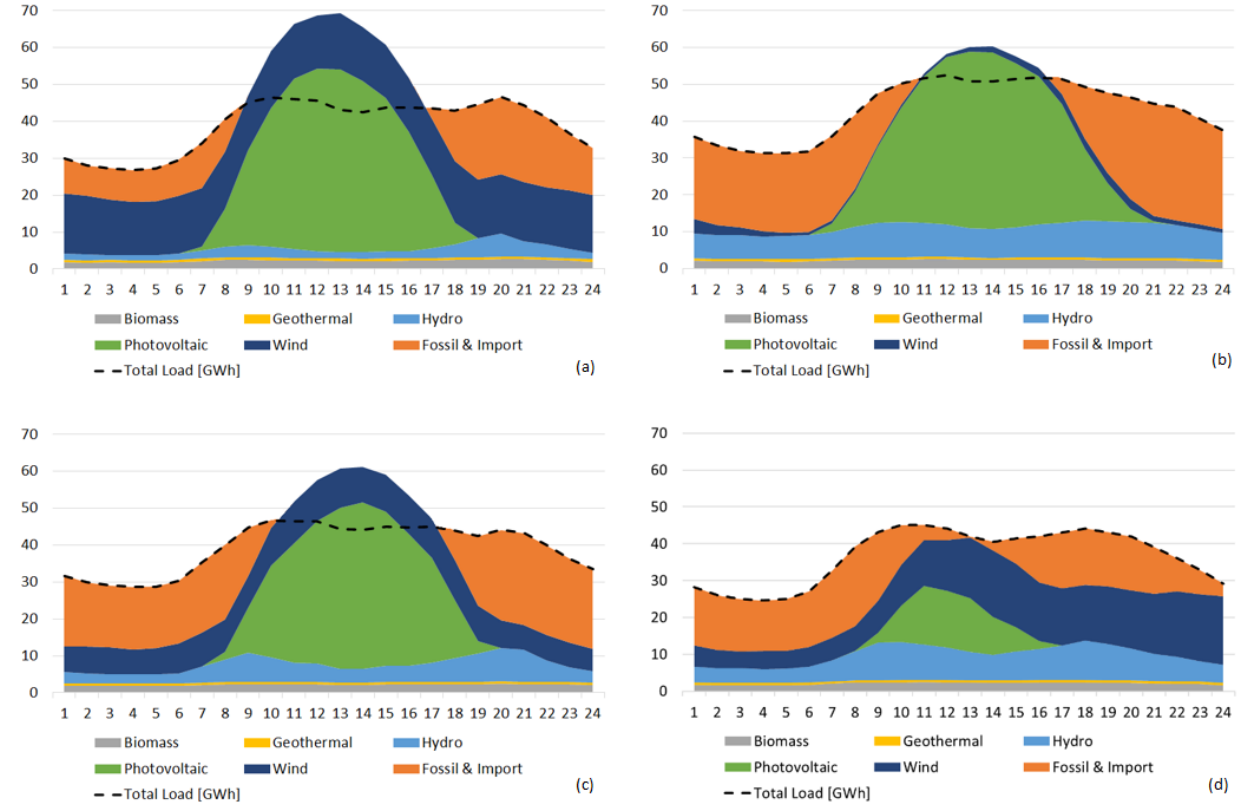
Figure 6. Case 2 with four times the production from photovoltaic and thrice the production from wind. Energy mix for the electric energy supply on ( a ) 21 March, ( b ) 121 June, ( c ) 20 September and ( d ) 20 December 2019.